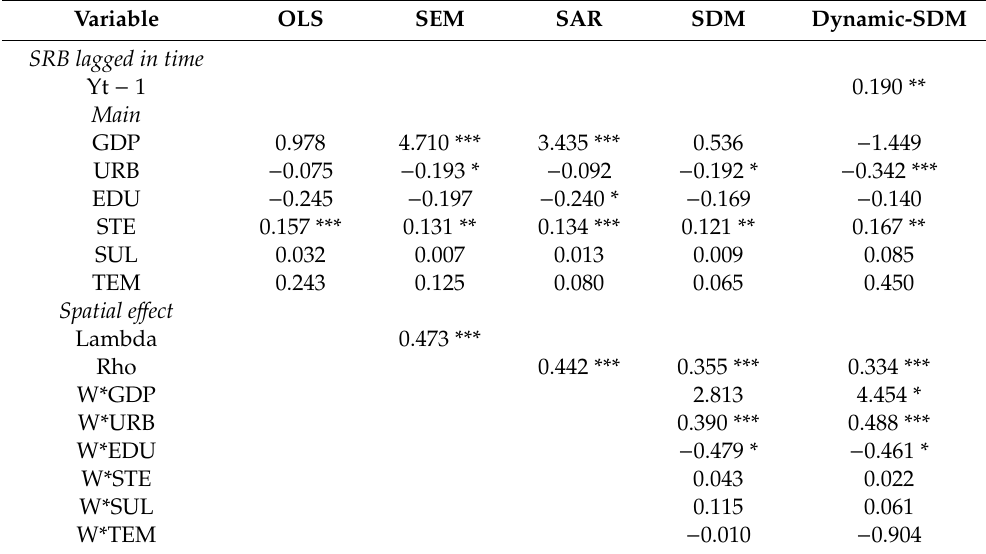
Table 3. Estimation of the regression of SRB on OLS and spatial panel models from 1982–2015. Variable OLS SEM